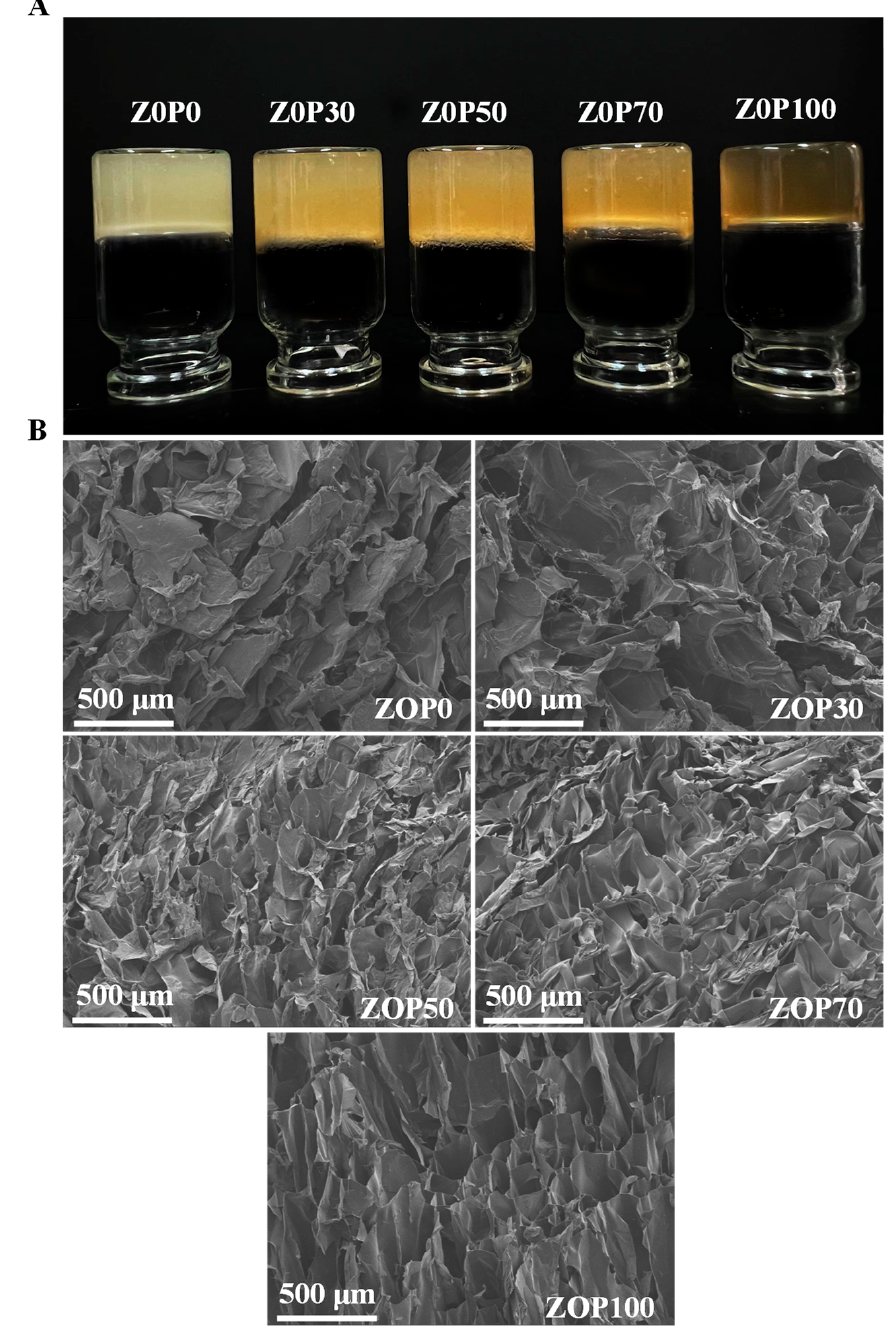
Figure 5. Photographs of different prepared hydrogels ( A ); SEM images of the cross-sectional morphology of the freeze-dried hydrogels ( B ).